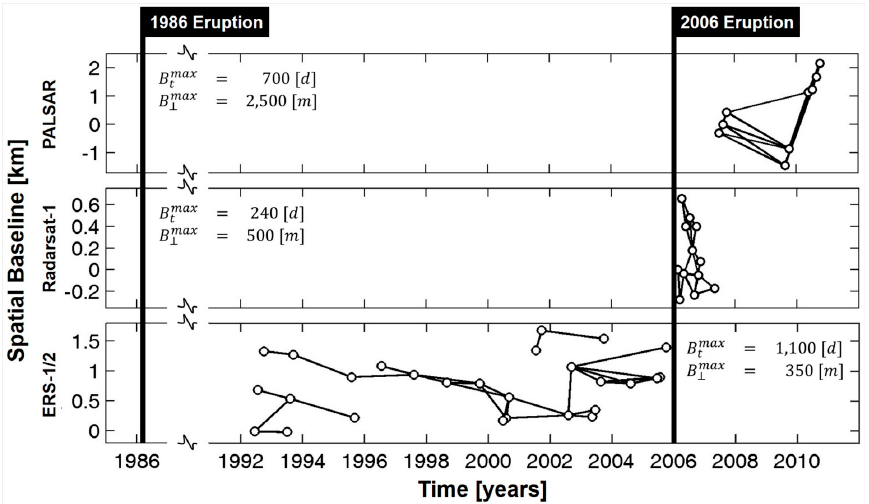
Figure 4. Time and spatial baseline diagrams indicating SAR pairs selected for interferometric processing. attributed to the newly deposited material.